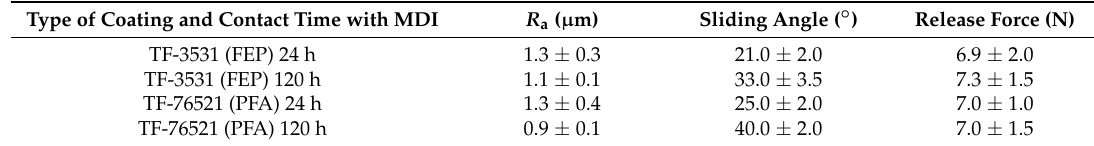
Table 2. Roughness R a (µm), sliding angle (°), and release force of PUR foam (N) on of the FEP and PFA coatings studied. After 24 h and 120 h.